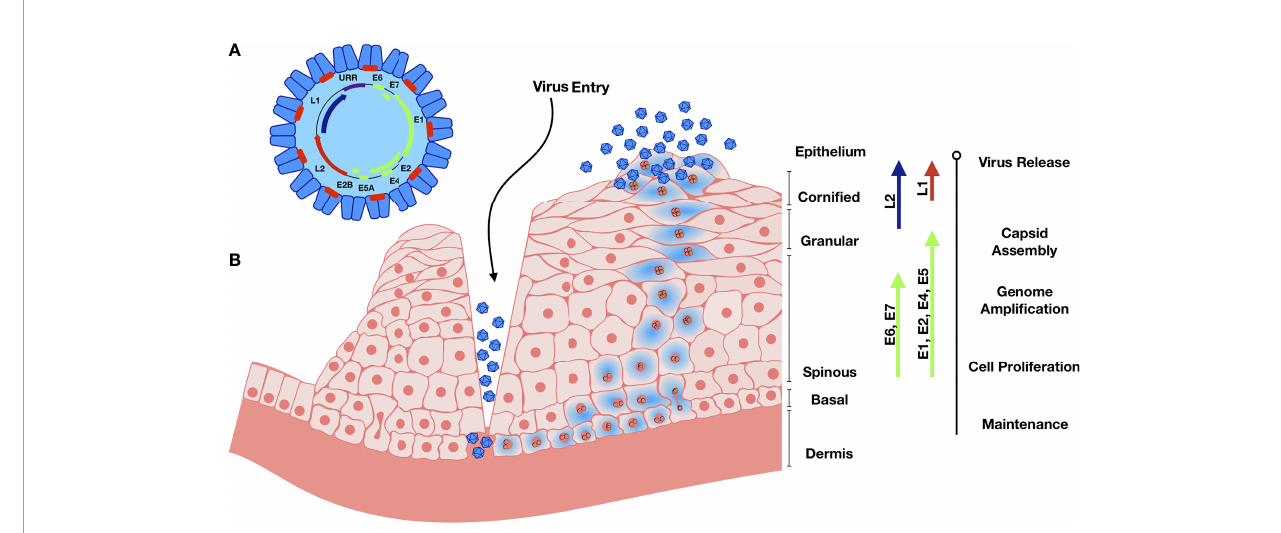
FIGURE 1 | Genome organization and Life cycle of HPV. (A) The circular dsDNA genome is represented in the black circle. Position of early genome is represented by green, and L1 and L2 in blue and red respectively. URR – Upstream Regulatory Region. (B) Abrasion provides HPV access to basal keratinocytes. Viral DNA replication relies on the host DNA replication machinery and is supported by the early viral proteins E1 and E2. The viral genome replicates in the infected basal and stem cells and establishes HPV episome copies, which split between the daughter progeny as cells divide. The early viral proteins E6 and E7 stimulate the continued proliferation. Upon terminal cell differentiation in the upper epithelium, L1 and L2 become activated to package the high number of viral DNA copies. E4 disintegrates the cytokeratin fi laments and the virus is released as keratinocyte remnants are sloughed off at the epithelial